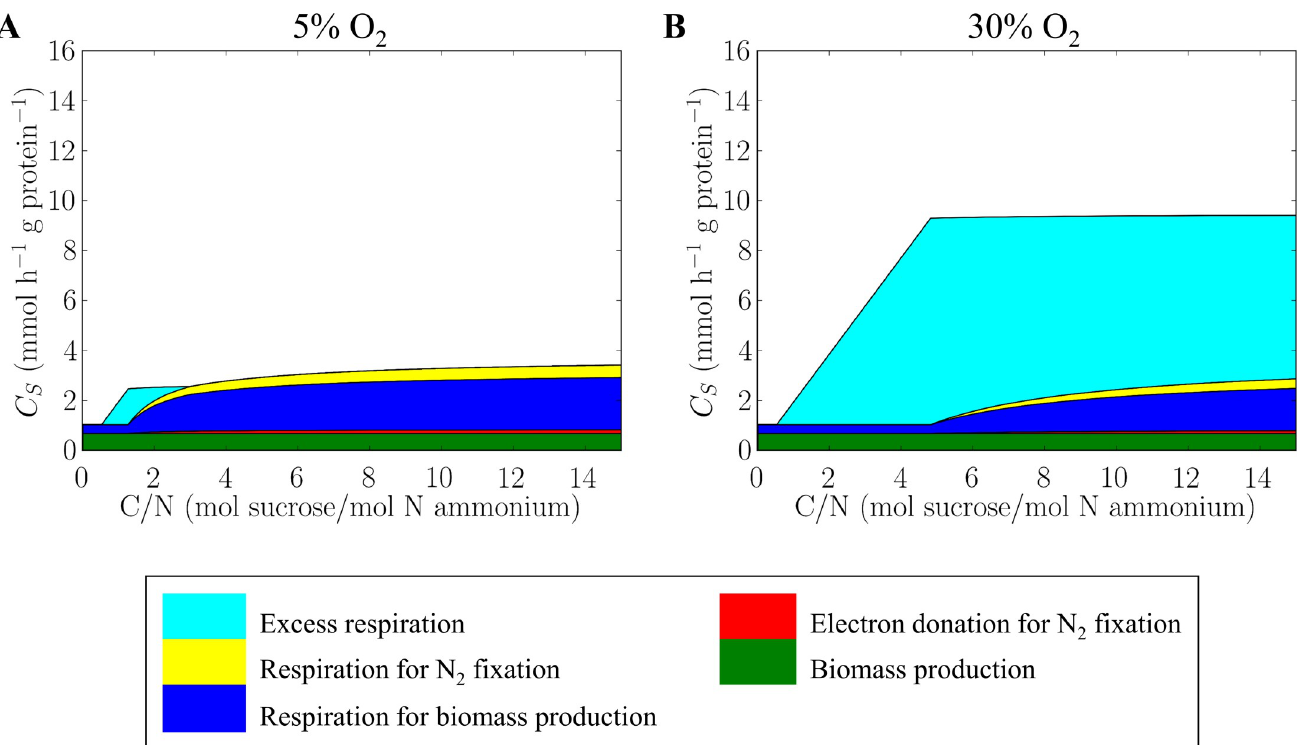
Fig 4. Carbohydrate fluxes for different purposes. (A) 5% O 2 and (B) 30% O 2 , where 100% O 2 equals 225 μ M thus approximately O 2 saturation under normal air composition at 30˚C. Dilution rate is constant at 0.15 h -1 . A schematic of carbon allocation is provided in S1 Fig, where the same color scheme is used for each carbohydrate